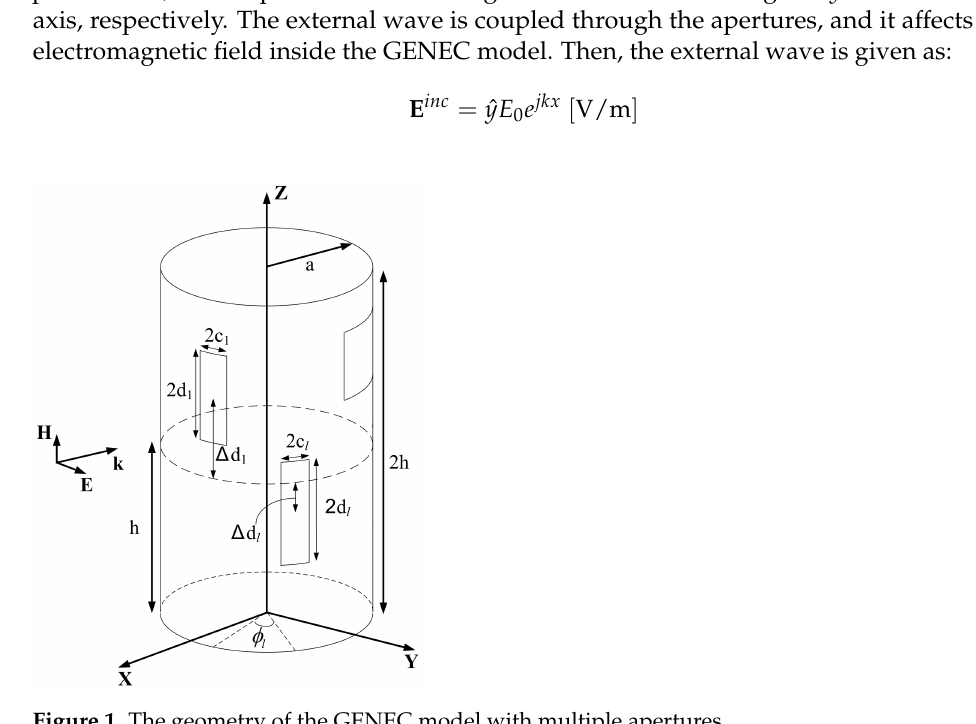
Figure 1. The geometry of the GENEC model with multiple